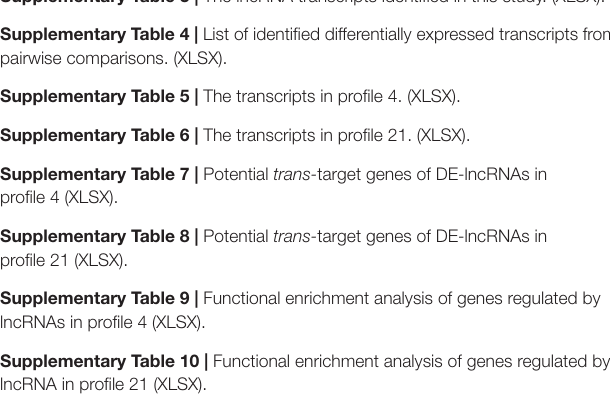
Supplementary Table 2 | Overview of raw data output and quality assessment. (XLSX). Supplementary Table 3 | The lncRNA transcripts identified in this study. (XLSX).